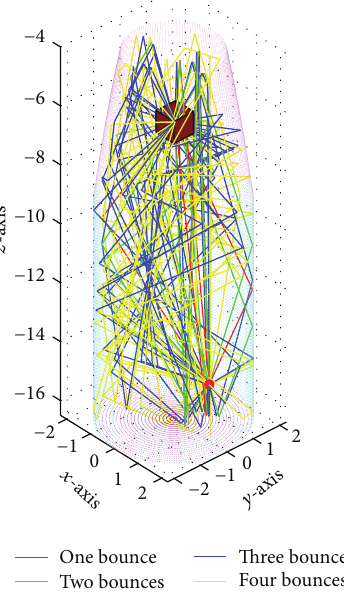
Figure 5: Ray-path visualization of cumulative rays up to four bounces inside the space